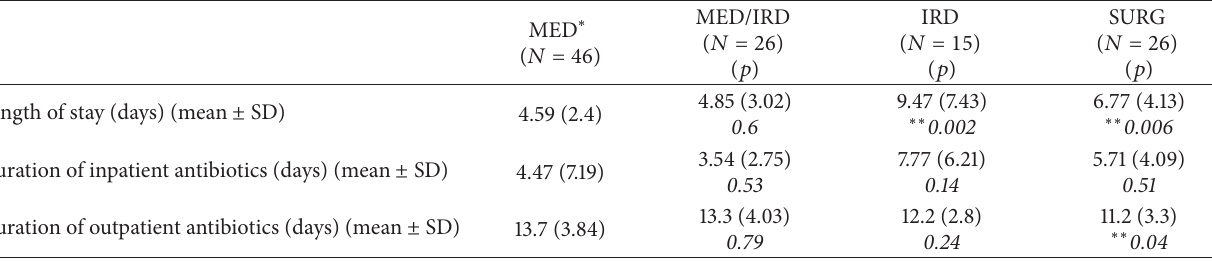
Table 4: Outcomes by treatment